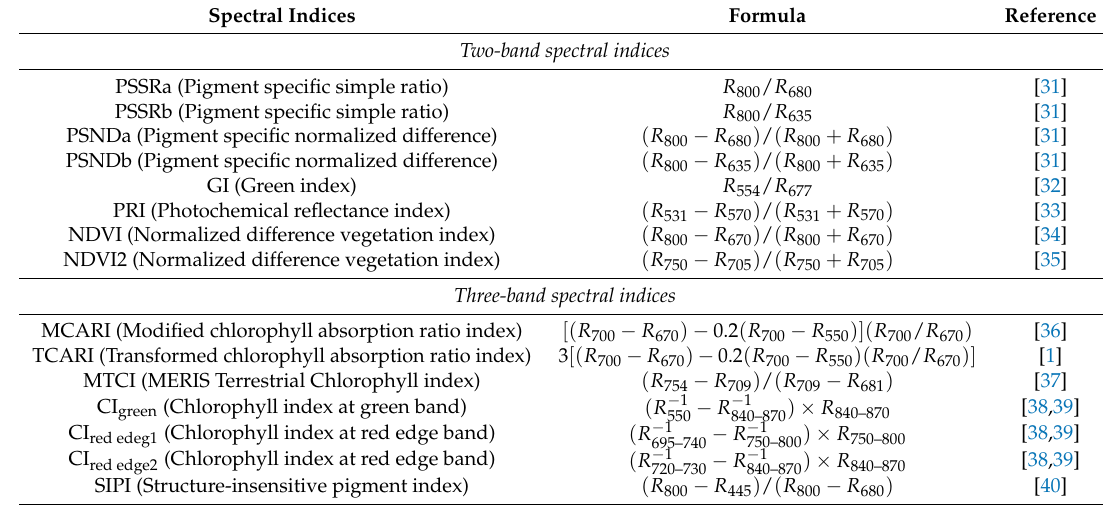
Table 1. Published spectral indices tested in this study. Indices were sorted according to their band